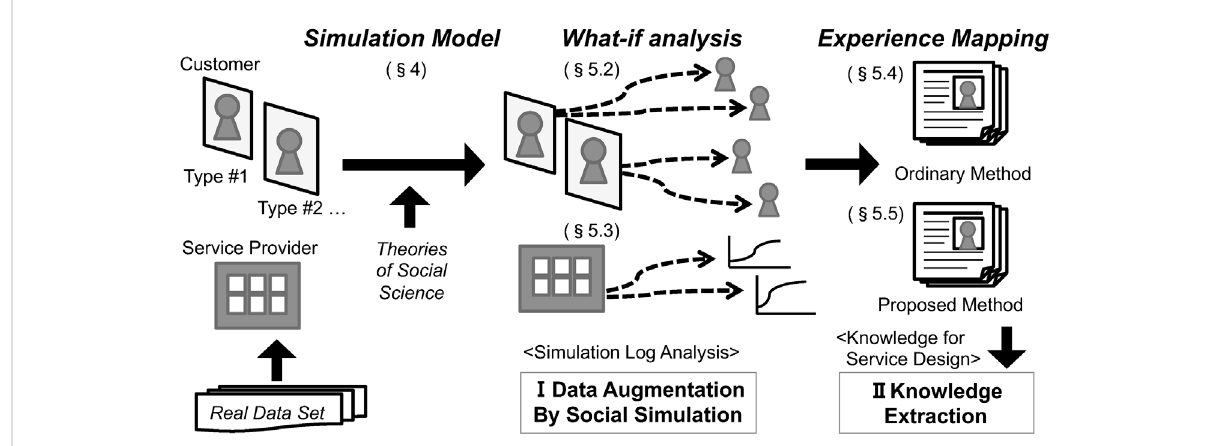
FIGURE 1 Knowledge extraction framework on social simulation results for service design.